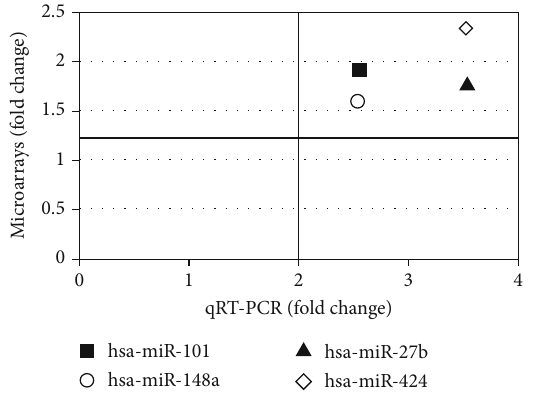
Figure 5: Comparison of fold change values (T1D vs. control group), obtained by the microarrays and qRT-PCR methods, for the selected di ff erentially expressed microRNAs. The same samples (11 T1D patients and nine controls) were used for both